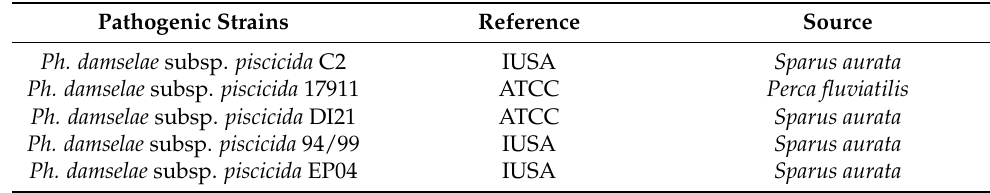
Table 1. Pathogenic strains used in testing antagonistic